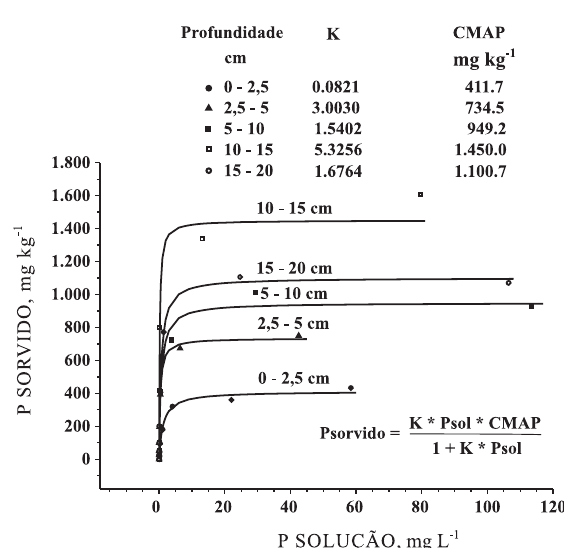
Figura 2. Fósforo sorvido em diferentes profundida- des de um Alissolo Crômico órtico típico sem aplicação de dejeto líquido de suíno e ajuste matemático pelo modelo de